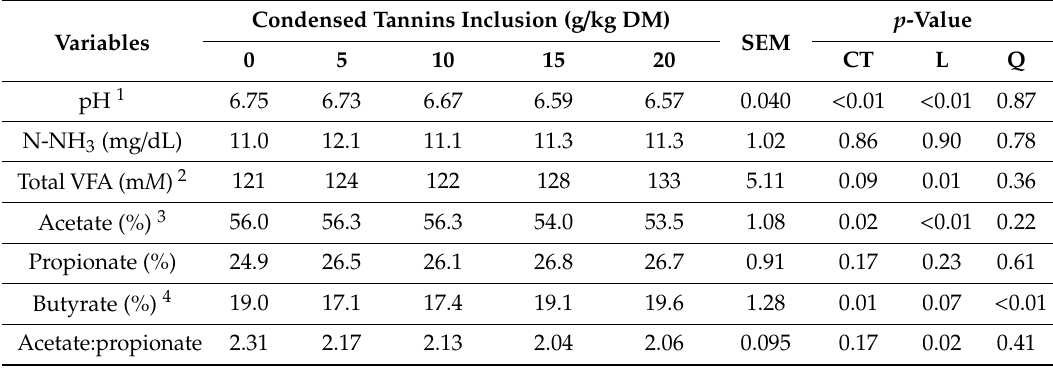
Table 6. Ruminal pH, ammonia nitrogen (N-NH 3 ), and volatile fatty acids in steers receiving diets with increasing levels of condensed tannins extract from Acacia mearnsii